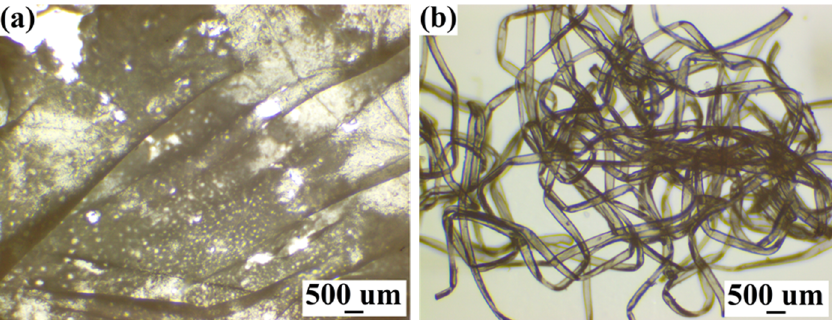
Figure 1. Optical microscopic images of undissolved components separated from ( a ) H 2 SO 4 aqueous solvent system and ( b ) NaOH/urea aqueous solvent system.